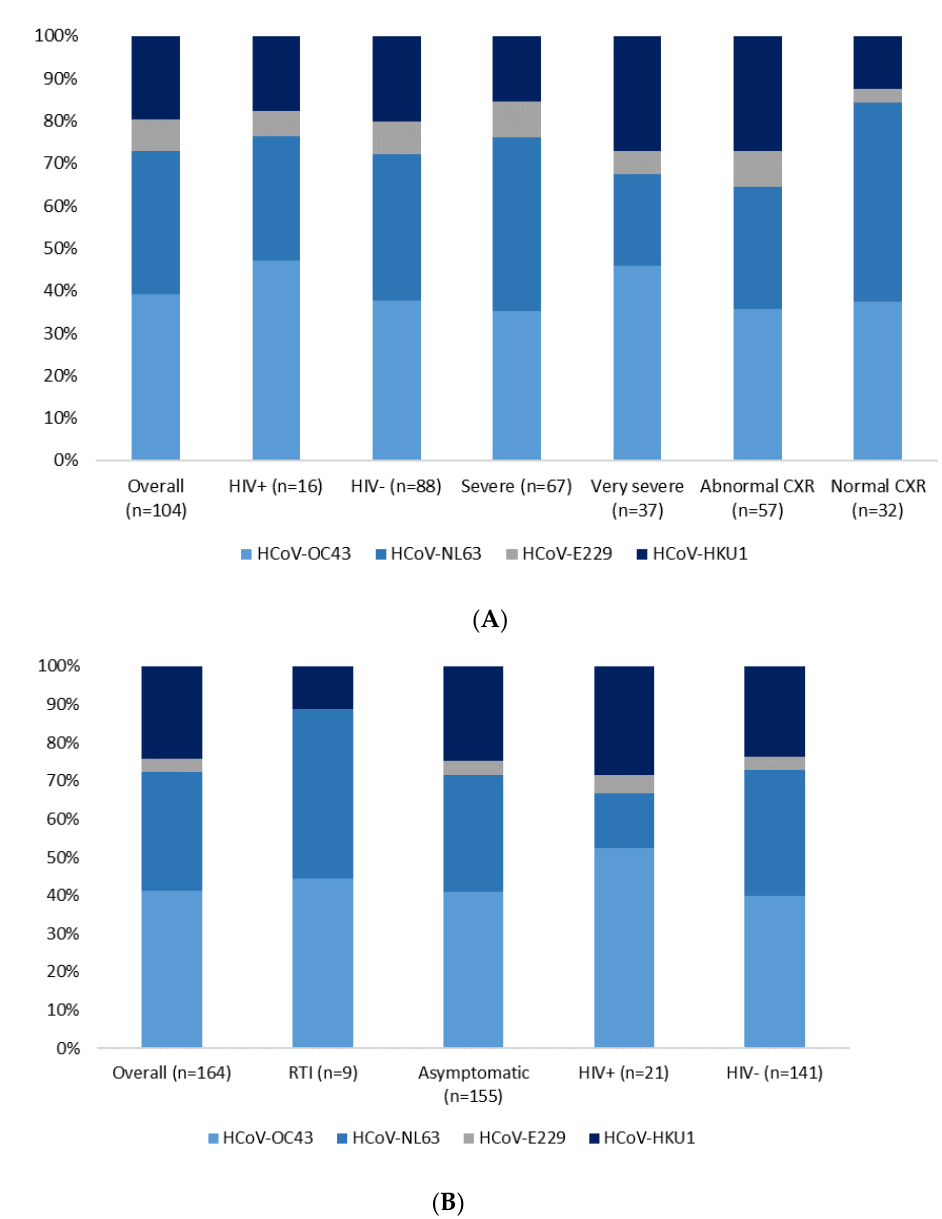
Figure 3. Distribution of HCoV species among HCoV positive cases (Panel ( A )) and controls (Panel ( B )).